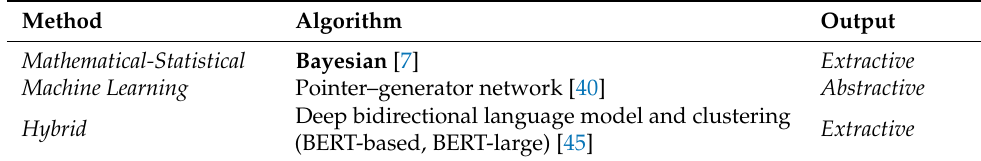
Table 7. Most cited algorithms for each